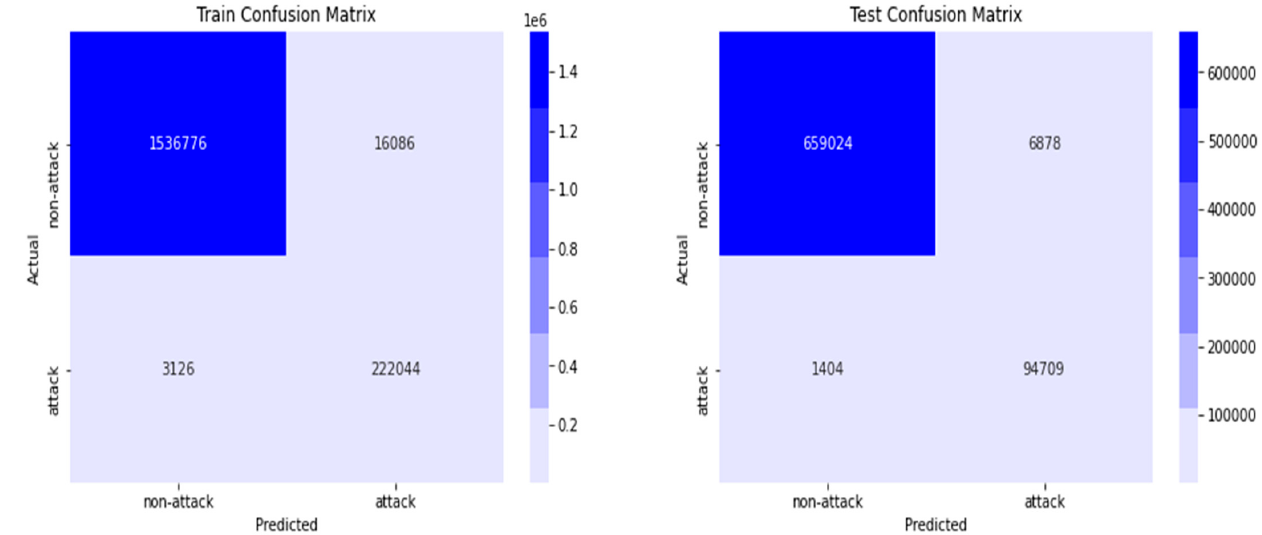
Figure 6. Train and Test confusion matrix.